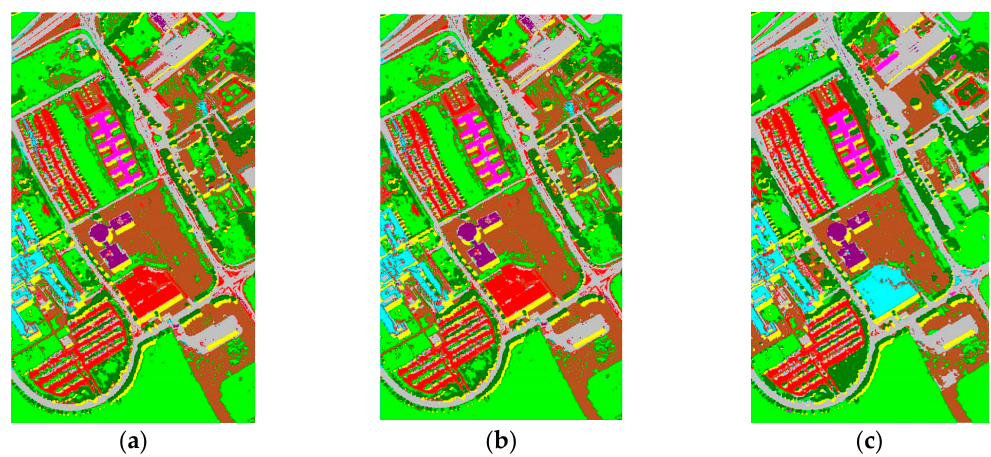
Figure 5. Classification maps achieved on the Pavia University dataset. ( a ) SVM; ( b ) SVMt; ( c ) TSVM. Table 4. The accuracy of three methods.